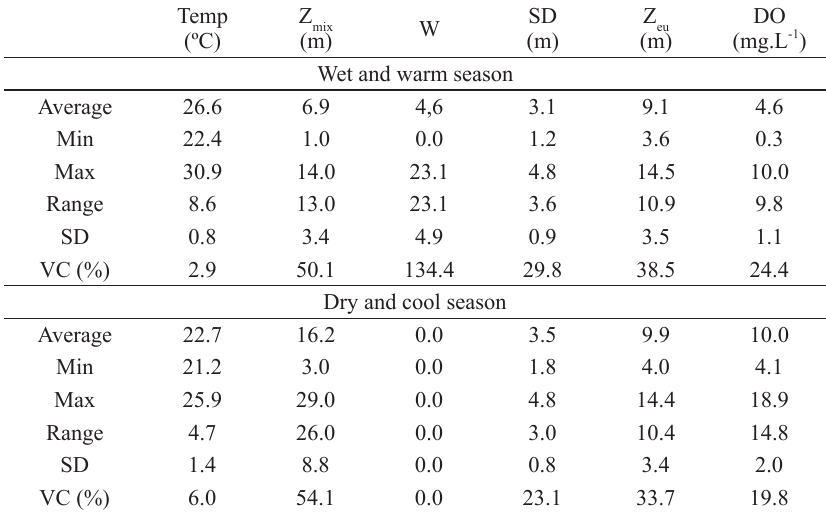
Descriptive statistics for physical and physic-chemical variables in water